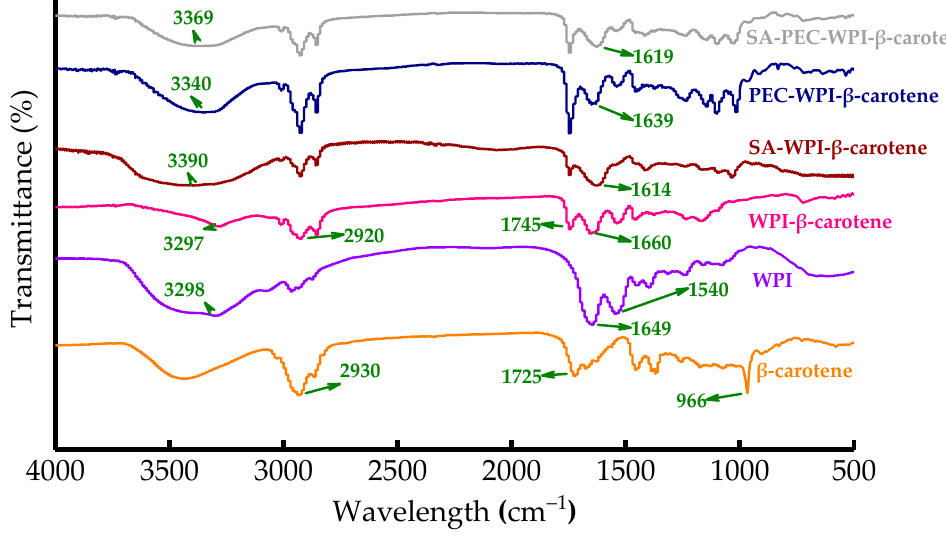
Figure 11. FTIR spectra of β -carotene, WPI and WPI, SA-WPI, PEC-WPI, SA-PEC-WPI stabilized β -carotene emulsions. FTIR: Fourier transform infrared; SA: sodium alginate; PEC: pectin; WPI: whey protein